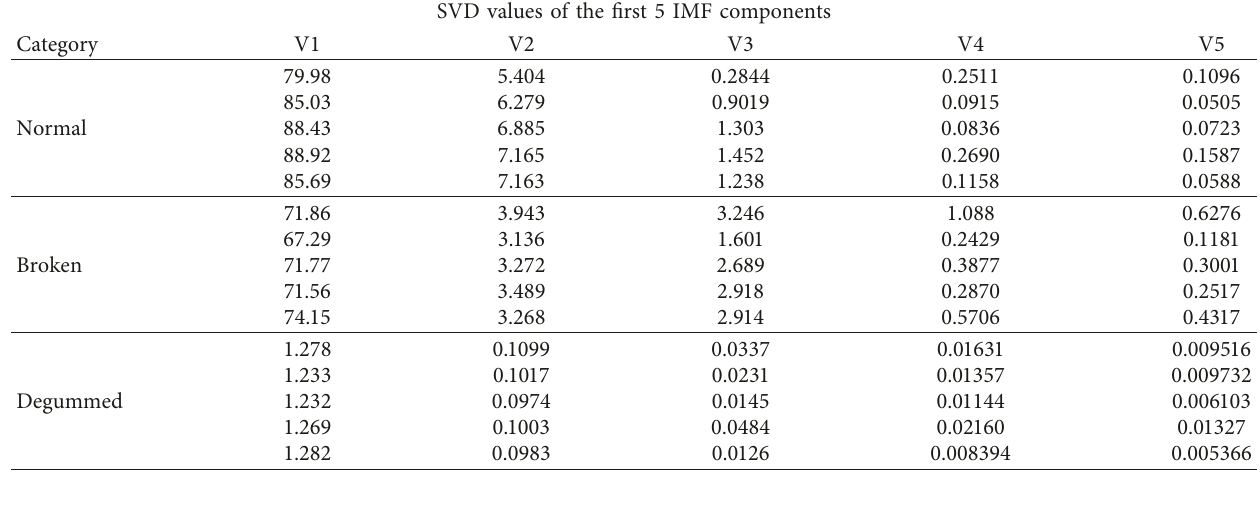
Table 1: SVD values of the IMF components of the three types of piezoelectric patches.